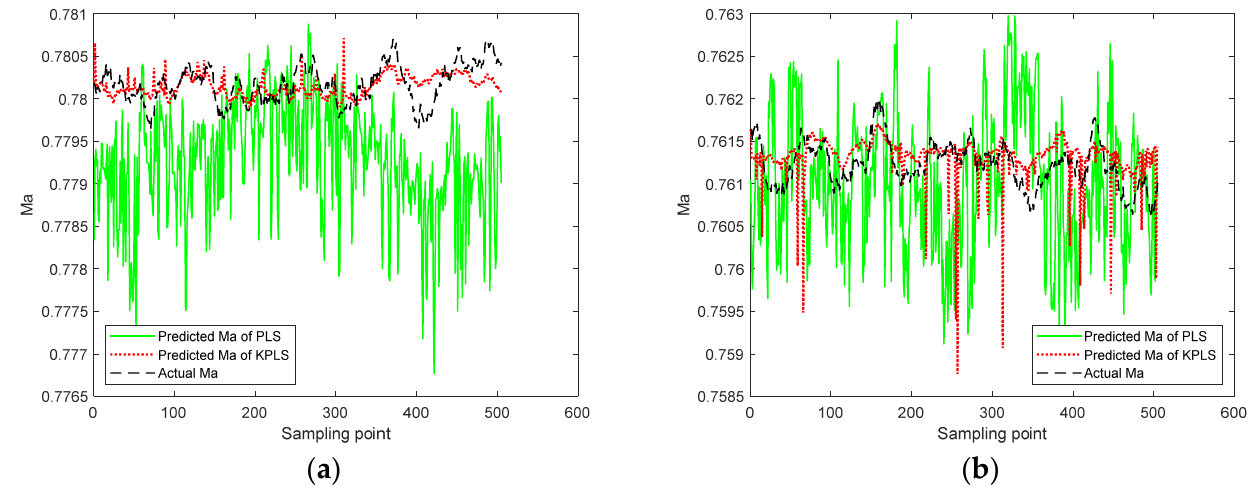
Figure 8. Multimode Mach number prediction results of the mean-value PLS and mean-value KPLS models. ( a ) Test data 1. ( b ) Test data 2.